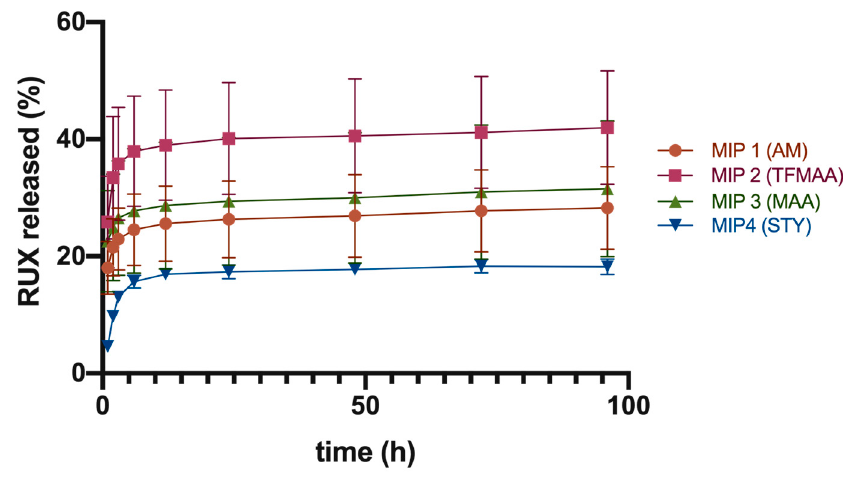
Figure 8. Cumulative drug release at pH = 7.4 in PBS + SDS 2%.